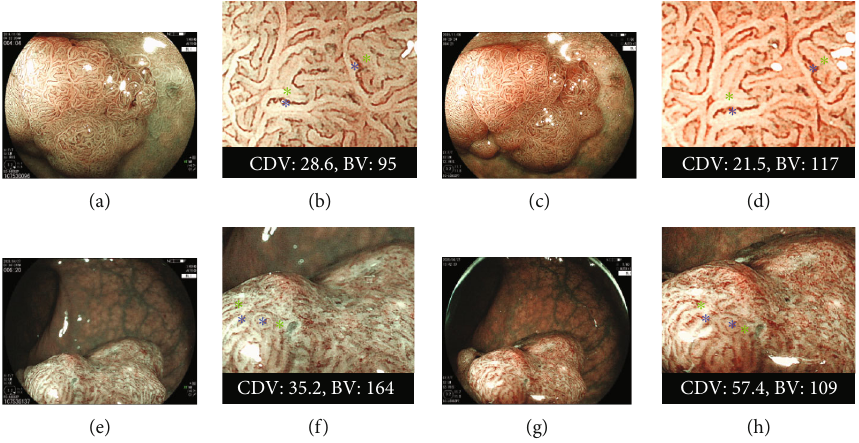
Figure 3: The comparison of Color di ff erence value (CDV) and bright value (BV) between the BLI-LED and BLI-LASER endoscopic systems. (a). A nonpolypoid of 20 mm on the rectum. Histopathology: high-grade adenoma. BLI-LED: JNET Type 2B. (b) The CDV and BV for two points between the vessels (the red signs) and surrounding whitish area (the white signs) with BLI-LED were 28.6 and 95. (c) BLI-LASER of the same tumor: JNET Type 2A. (d) The CDV and BV were 21.5 and 117. (e) A nonpolypoid of 25mm on the rectum. Histopathology: T1b cancer. BLI of LED: JNET Type 3. (f) The CDV and BV were 35.2 and 164. (g) BLI-LASER of the same tumor: JNET Type 3. (h) The CDV and BV were 57.4 and